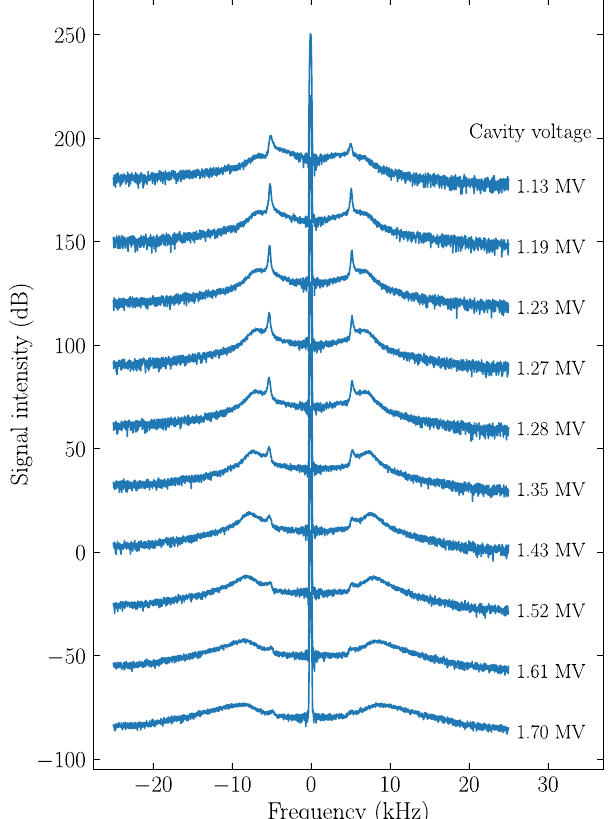
FIG. 11. Beam responses measured under different cavity voltages. The beam current was fixed at 350 mA. An offset of 30 dB was appended between neighboring traces. The center frequency corresponds to an rf frequency of 500.113 80 MHz at this measurement. Each trace was obtained by averaging over ten sweeps. The RBW was 100 Hz and the phase-modulation amplitude was 0.20° p-p. Measurement date: March 11,